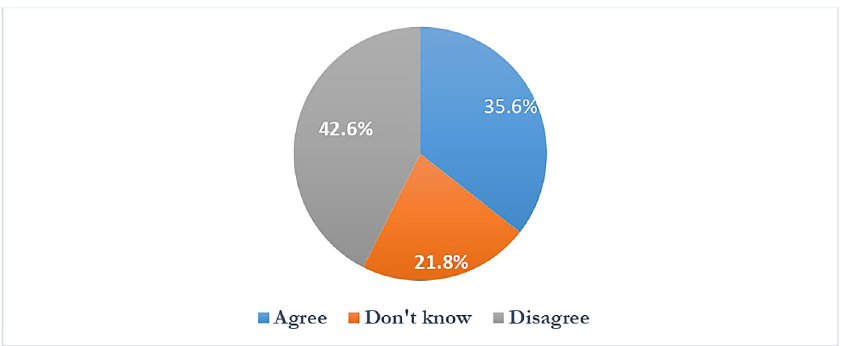
Figure 8. Students reaction for online lectures after the